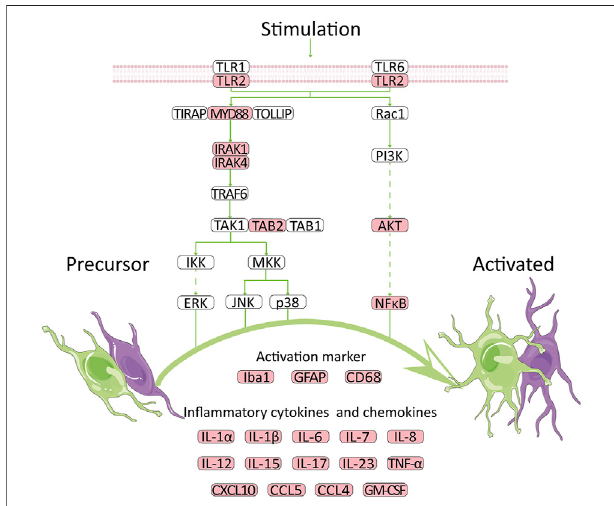
FIGURE 7 | Potential mechanism for high expression of TLR2 to promote VaD. The network is summarized according to GSE122063 database and public KEGG pathway. Red indicates the upregulated